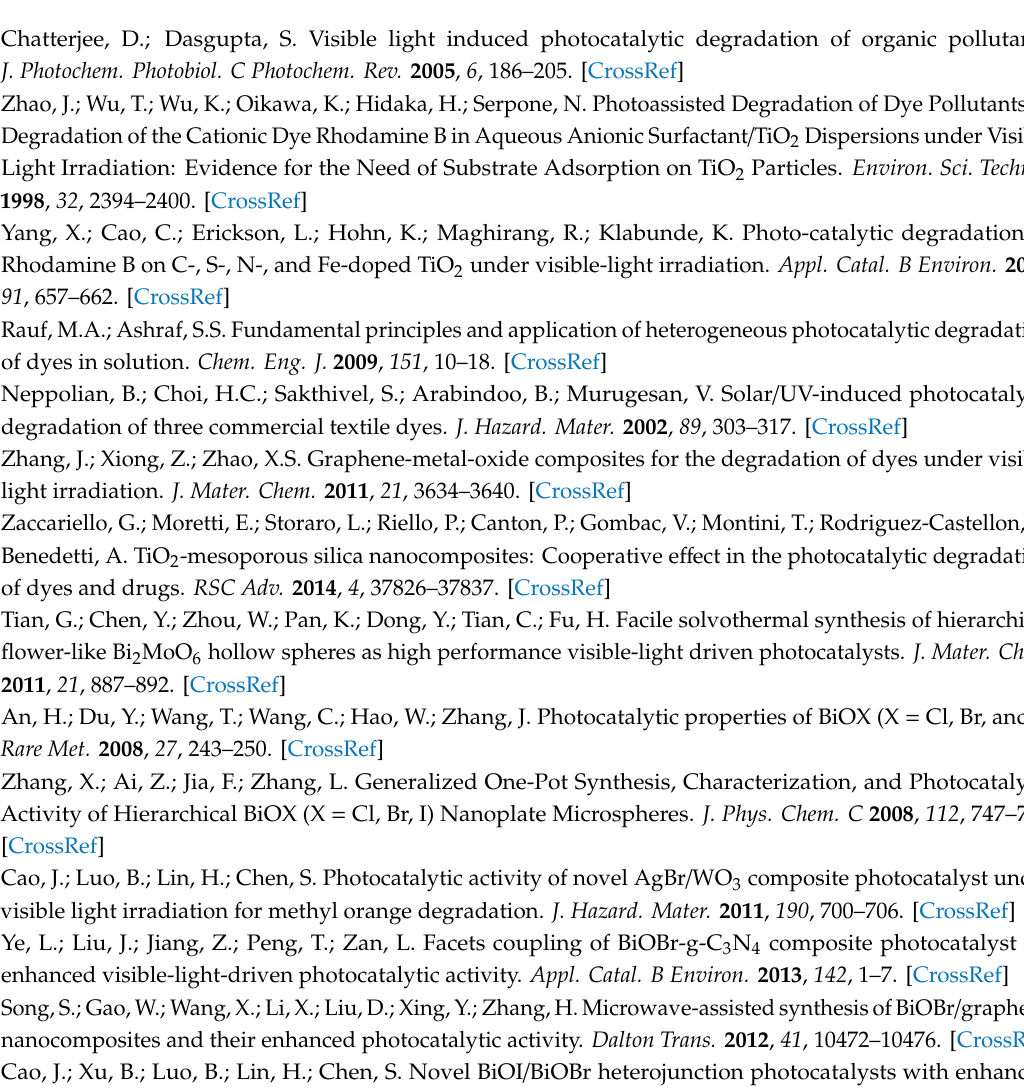
the as-prepared samples; Table S2: Magnetic parameters of the as-synthesized samples; Table S3: Comparison of photodegradation ratio using di ff erent photocatalyst under visible light irradiation reported in the past ten years. Author Contributions: Conceptualization, T.X. and L.X.; methodology, J.Y. and J.H.; formal analysis,